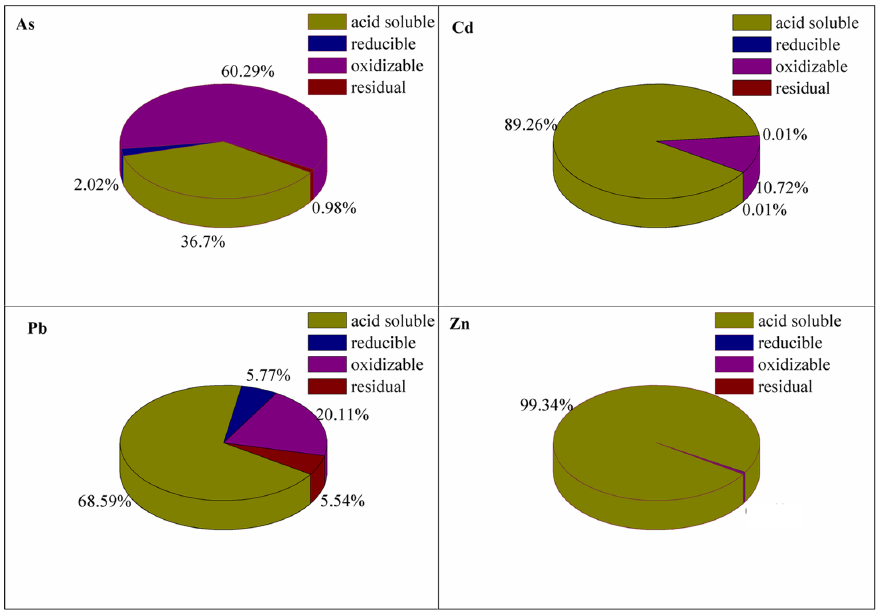
Figure 3. Chemical fractions of arsenic and heavy metal species in the ASS by the BCR sequential extraction procedure.